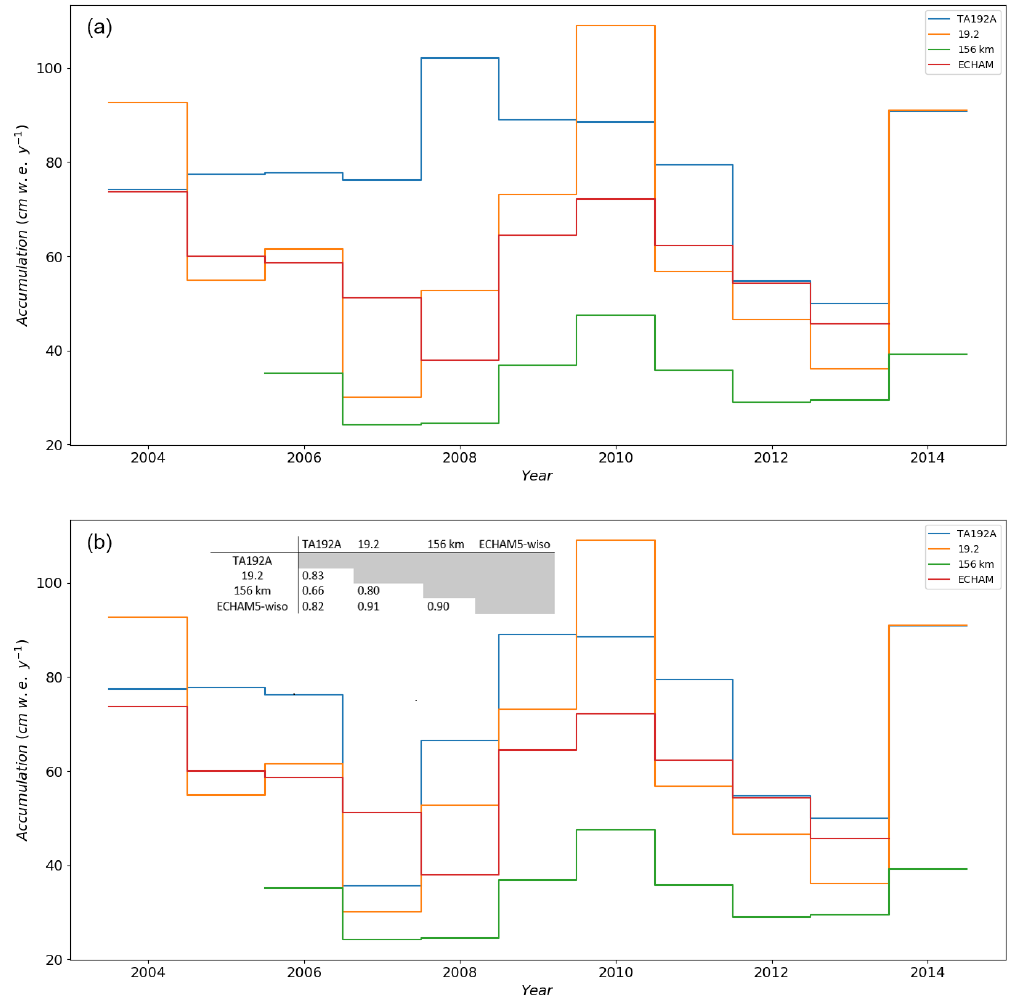
Figure 4. Annual accumulation (cmw.e.yr − 1 ) estimated from the layer counting in the TA192A firn core (blue line), measured at the closest stake point 19.2 (orange line), from the 156 km network stake data (green line) and extracted from the ECHAM5-wiso model (red line), before (a) and after (b) adding the identification of summer 2008 in a time interval of low accumulation rates and skipped in the initial layer-counting approach due to the lack of a signal in the MSA record (thin green line in Fig. 2). Correlations between time series (TA192A series inferred from the second dating) are inserted in the lower plot, with all linear relationships being significant ( p < 0 .